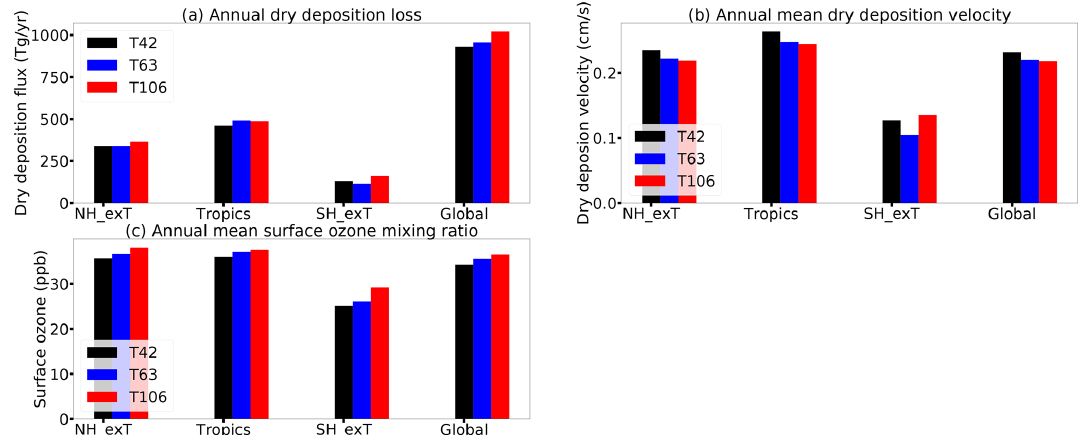
Figure 14. Ozone and dry deposition at three different resolutions (T42: 2.8 ◦ × 2.8 ◦ , T63: 1.9 ◦ × 1.9 ◦ , T106: 1.1 ◦ × 1.1 ◦ ) and the different regions: Northern Hemisphere extratropics (NH_exT: 90–30 ◦ N), tropics (30 ◦ N–30 ◦ S), Southern Hemisphere extratropics (SH_exT: 90– 30 ◦ S) and the whole Earth